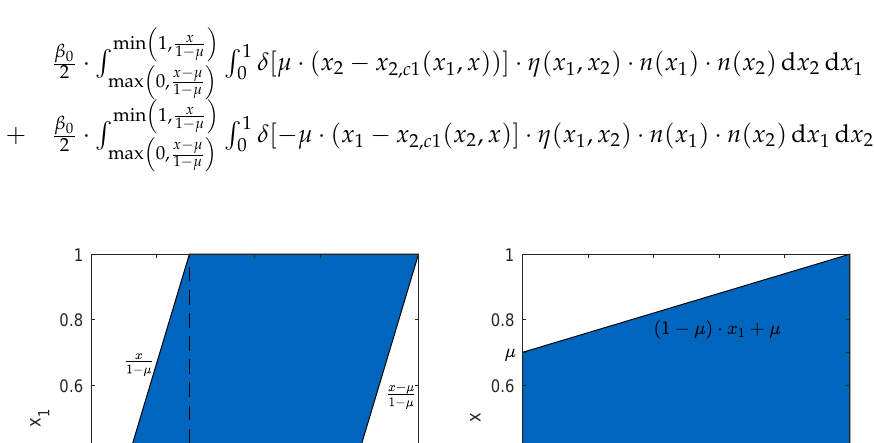
Figure A1. The limits of integration for the outer integral of the first term are thus max (cid:16) (cid:17) x 1 ≤ min 1, x . Switching the order of integration for the second term allows using the same 1 − µ argumentation yields